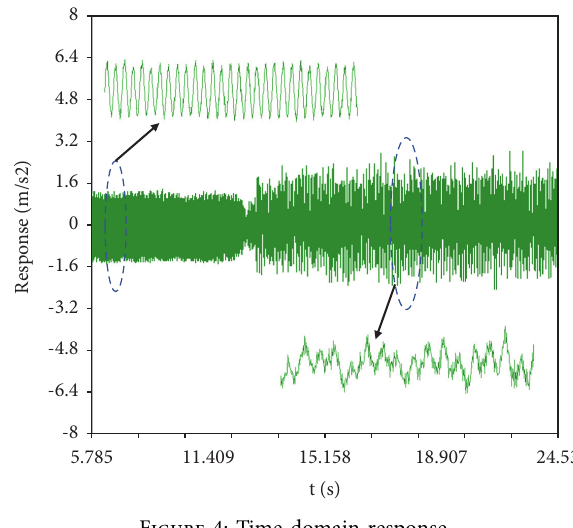
Figure 4: Time-domain response.